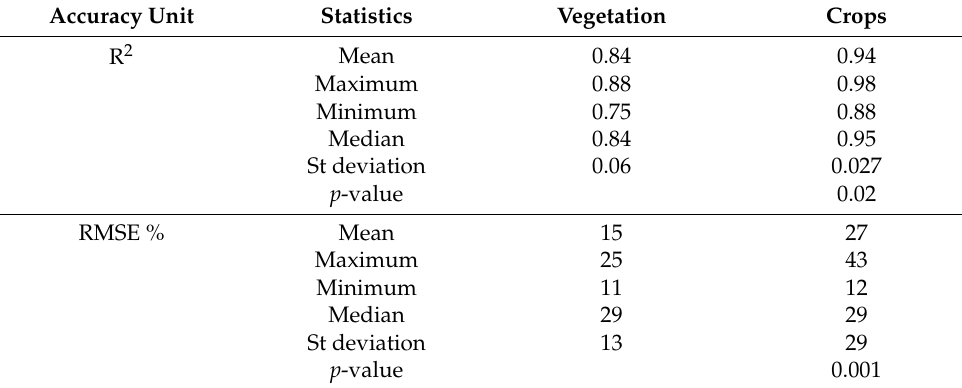
Table 8. Descriptive statistics for R 2 values and RMSE% for vegetation and crop types using pooled